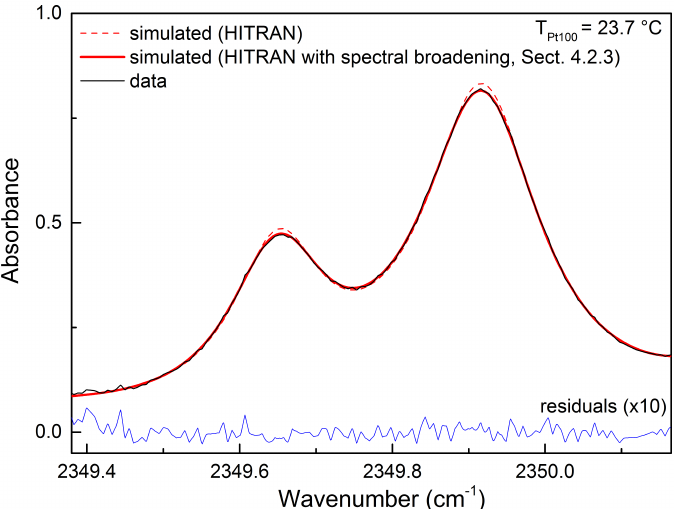
Figure 8. Absorption spectrum from Figure 4b with the best-fit data derived from simulations based on HITRAN 2012 and the fitting procedure described in Section 4.2.3.